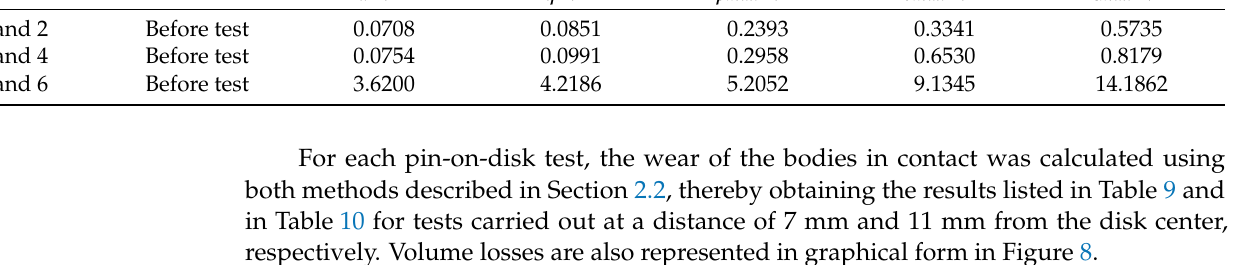
Table 9. Results for tests carried out at R t = 7 mm.